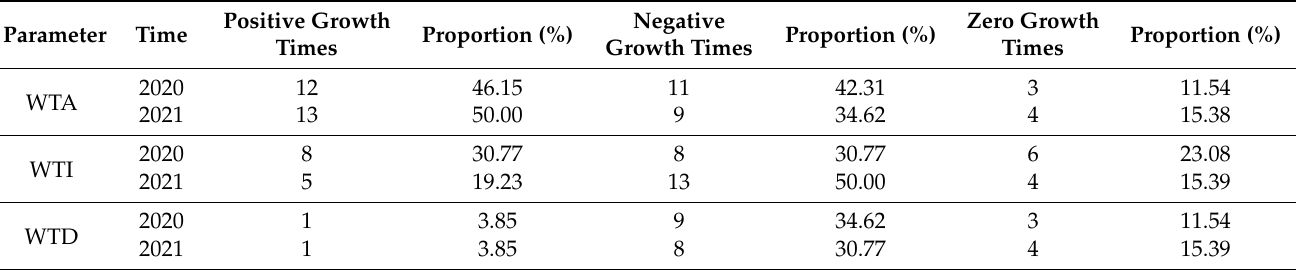
Table 6. The analysis results of the fixed base growth rate of the NPTHN safety level assessment parameters.